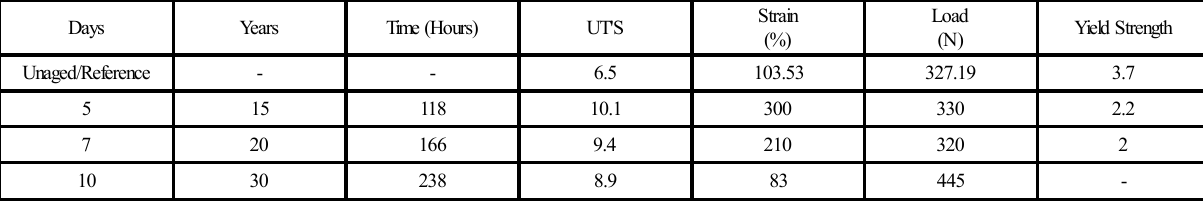
FIG. 8. SAMPLE OUT OF